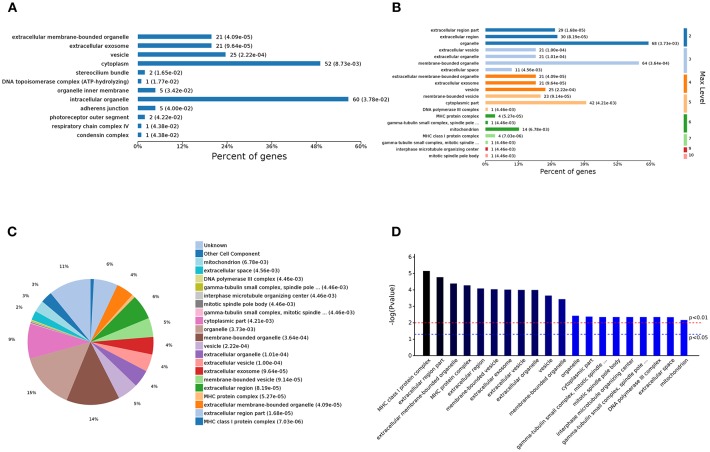
Analysis of 59 different cell component GOs. (A) Percent of genes associated with enriched cell components. (B) Levels of enriched cell components. (C) Expressed proteins associated with enriched cell components. (D) Significantly enriched cell components.